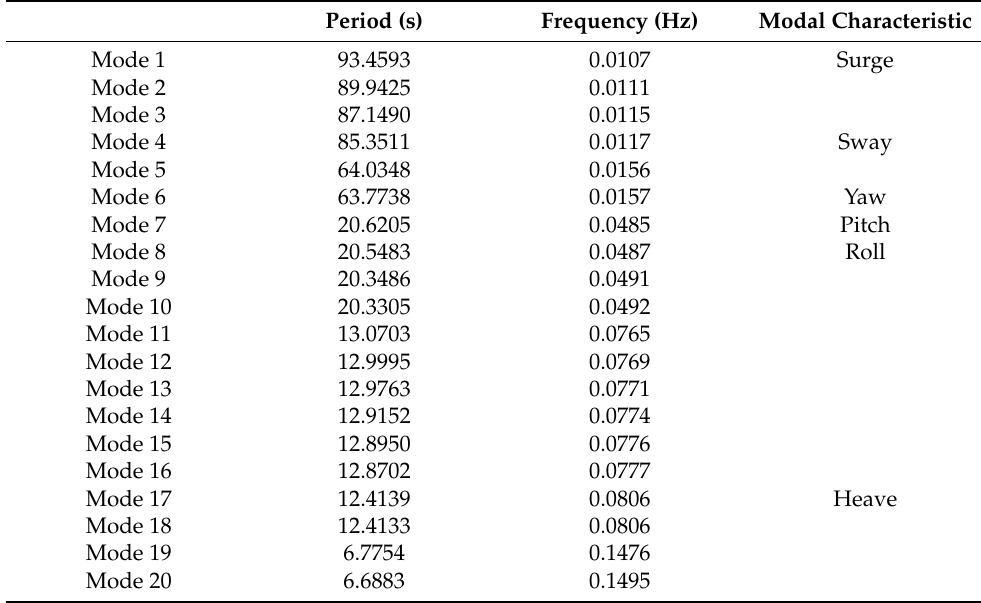
Table 8. The first 20 modes of the original wind turbine.